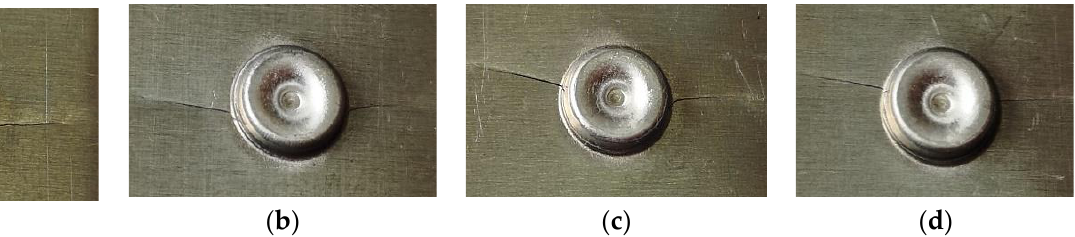
Figure 14. Failure forms of SPFC-AA joints with rivet heights of: ( a ) 6 mm; ( b ) 7 mm; ( c ) 8 mm; and ( d ) 9 mm.